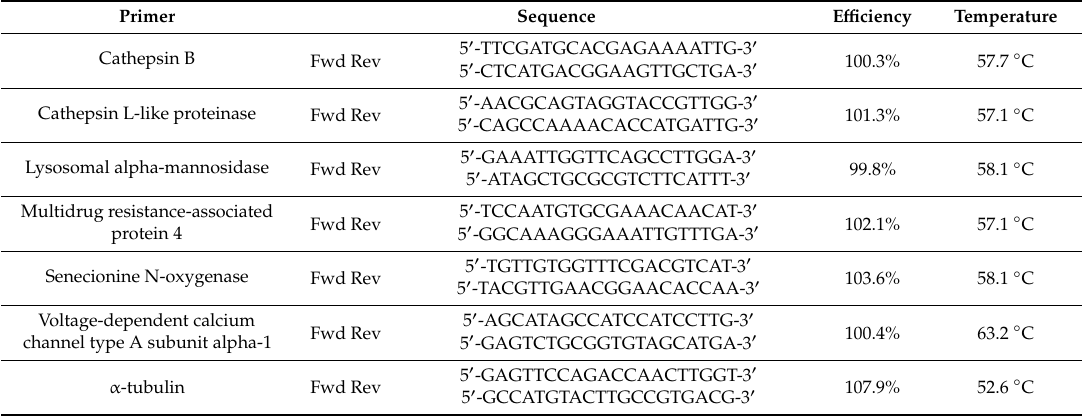
Table 1. Primers for the qRT-PCR-based quantification of spinosad-associated transcripts, as measured by next-generation sequencing (NGS). Abbreviations: Forward (Fwd) and reverse (Rev) primers. Primer Sequence E ffi ciency